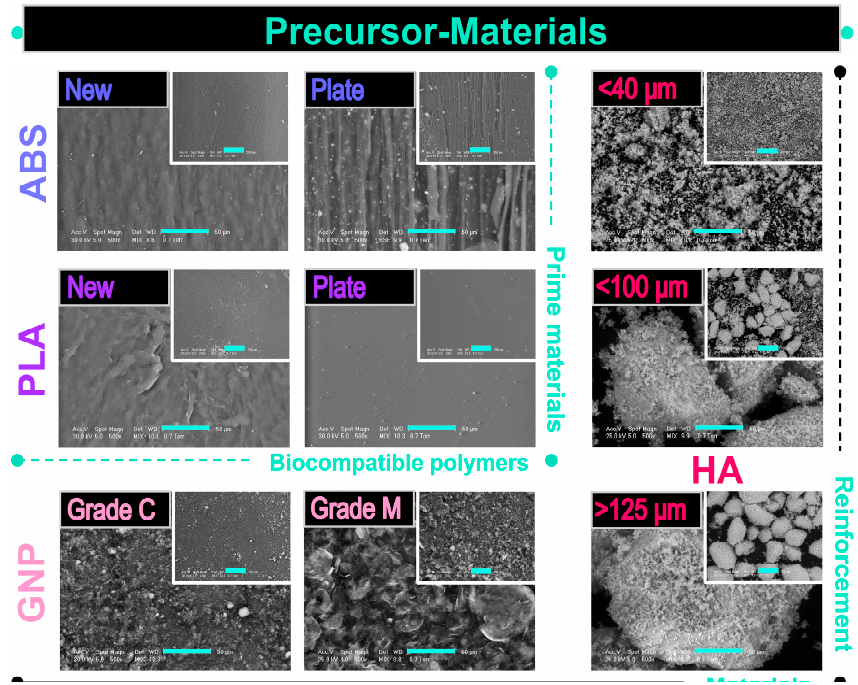
Figure 3. Representative SEM images of prime (ABS, PLA) and reinforcement (GNP, HA) precursor materials acquired at two magni fi cations; scale bar: 50 µm (main image) and 200 µm (inset image). The prime materials were investigated in two physical shapes, i.e., new, as-received (initial) materials and prepared plates from thin lamellas. tinuous and homogenous matrix (also known as the SAN matrix) and some light-